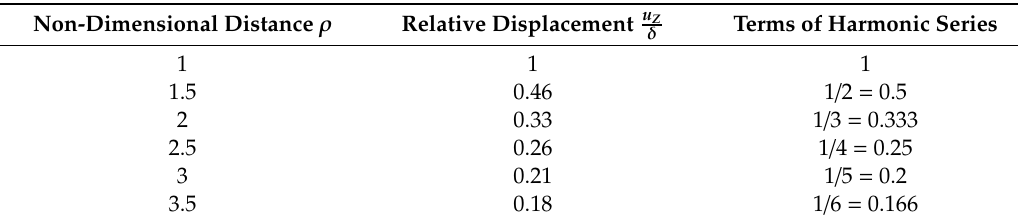
Figure A1. Surface deformation of a perfectly elastic body by an indentation of a circular flat punch. Table A1. Relationship between distance and displacement.